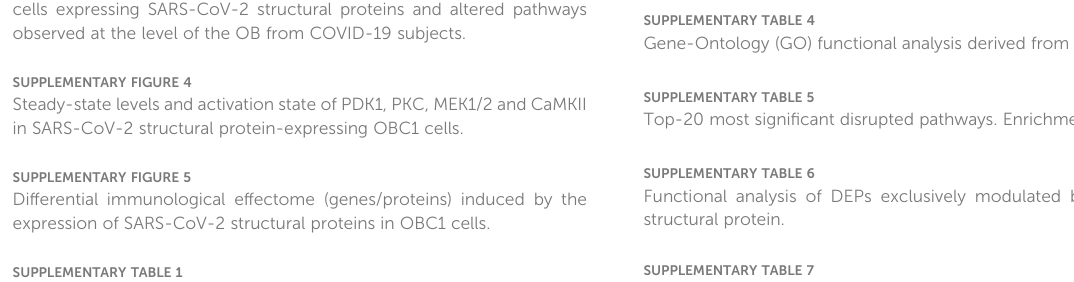
Gene-Ontology (GO) functional analysis derived from proteomics.